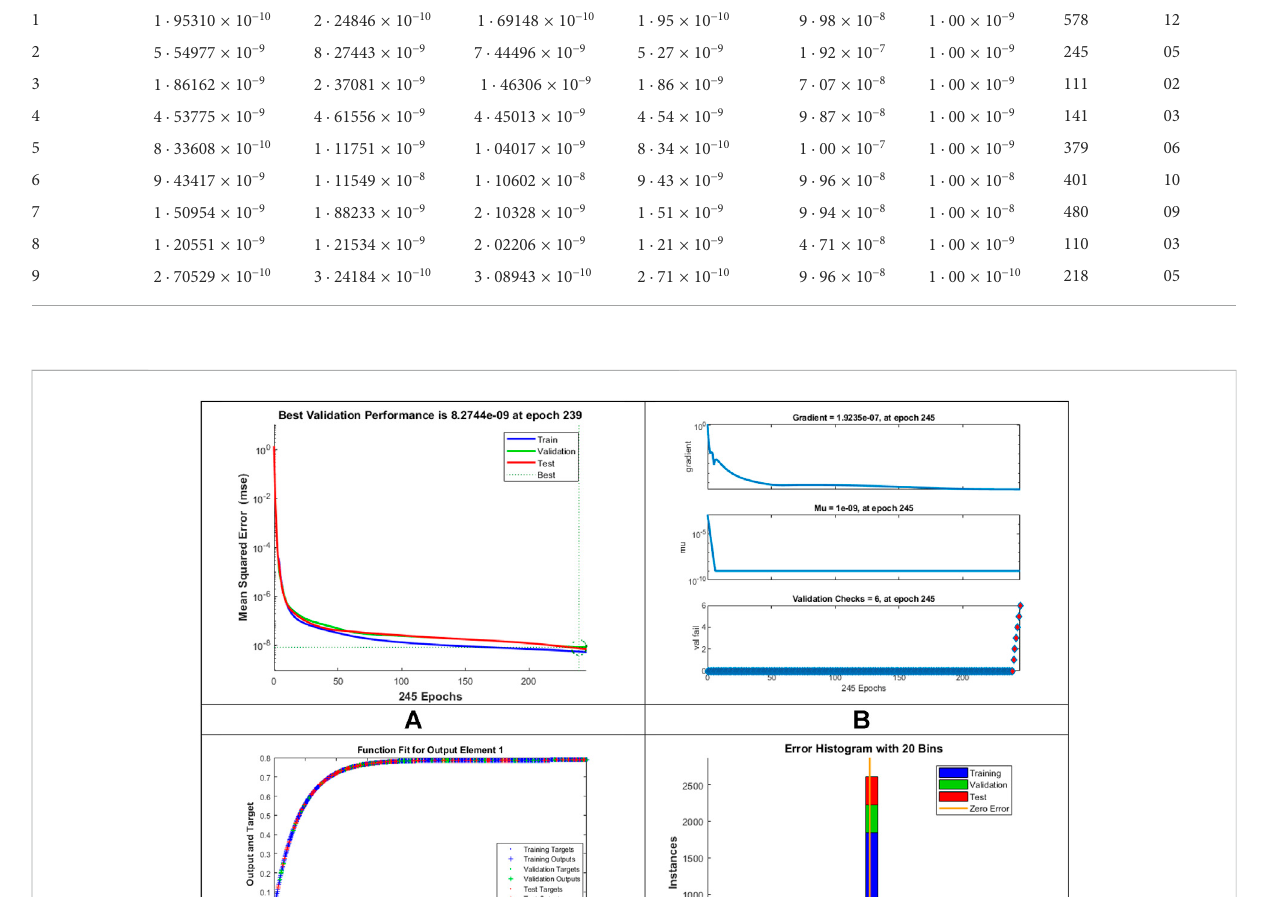
TABLE 1 LMLA-BPBB ’ s outcomes for scenario Ⅰ of MHD-WNF-HGA. Scenario